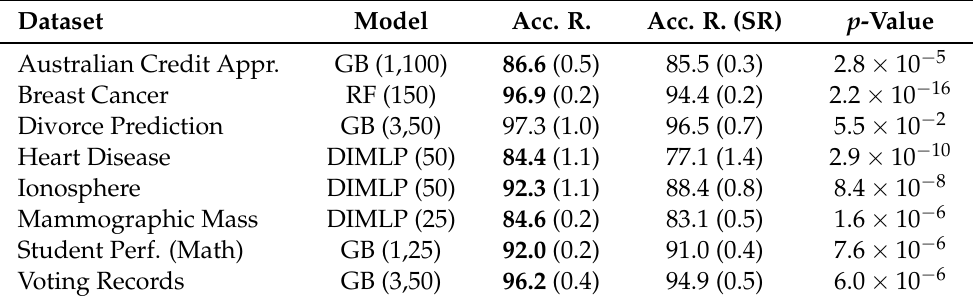
Table 10. Summary of the best average accuracies of rulesets produced by ensembles of DIMLPs or DTs. A comparison with SR (fourth column) was achieved through a Welch t -test; p -values are illus- trated in the last column. A bold number represents a significantly better average predictive